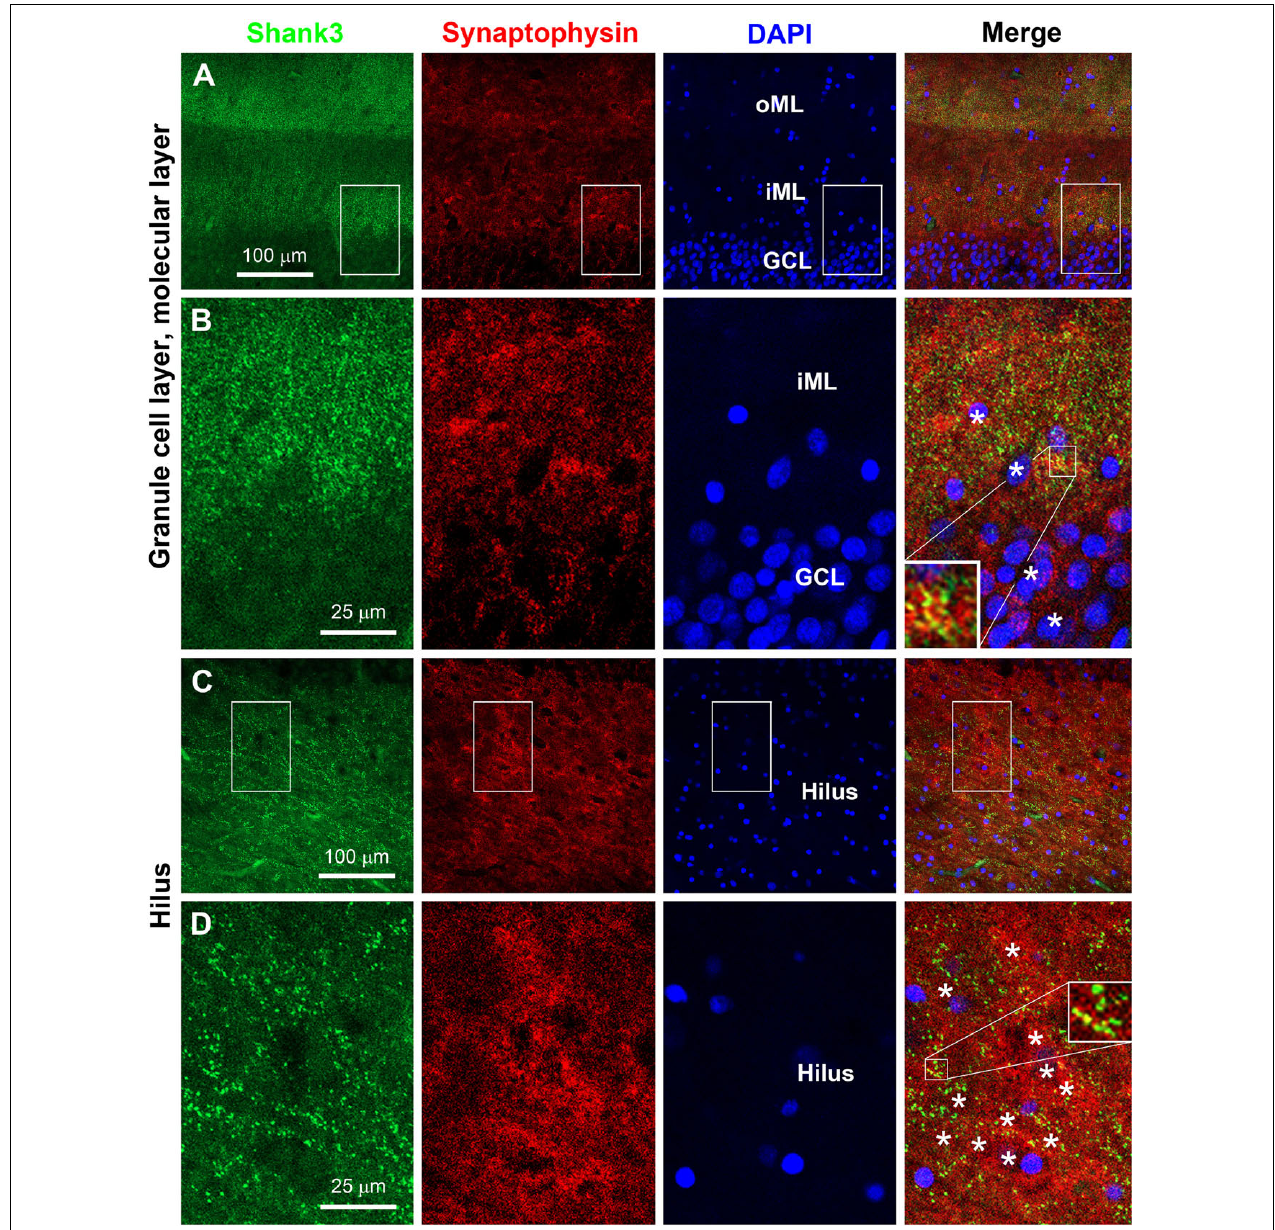
FIGURE 9 | Double immunofluorescent characterization of Shank3 localization relative to presynaptic terminals. Panels (A–D) are confocal images of Shank3, synaptophysin, and DAPI labeling in the dentate gyrus with one scan of 1- µ m section thickness. Sublemmal localization of Shank3 IR in the granule cells and large hilar cells is noticeable at high magnification (B,D) . Synaptophysin positive presynaptic terminals are punctate profiles, with a subset appeared to “colocalized” with Shank3 IR ( B,D , the most left panels, inserts). Neuroanatomical locations, enlarged zones, and scale bars are as indicated. *: location of neuronal